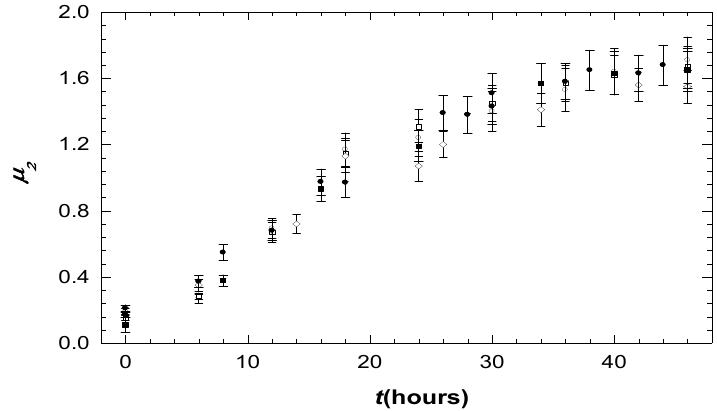
Figure 5. The variation of μ 2 with the time ( t ) as different wet foams containing different low angle grain boundaries evolve.